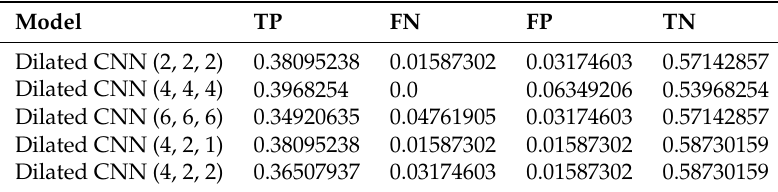
Table 3. Comparing True Positive, False Negative, False Positive, True Negative rates across different configuration of dilation rates for the convolution layers.